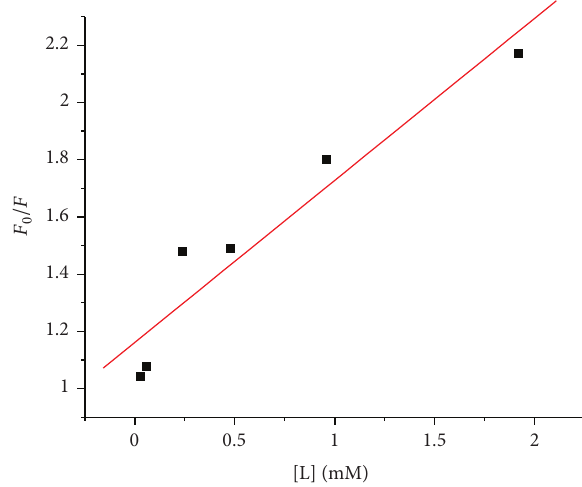
F 3: e Stern-Volmer plot for pentobarbital-TTR